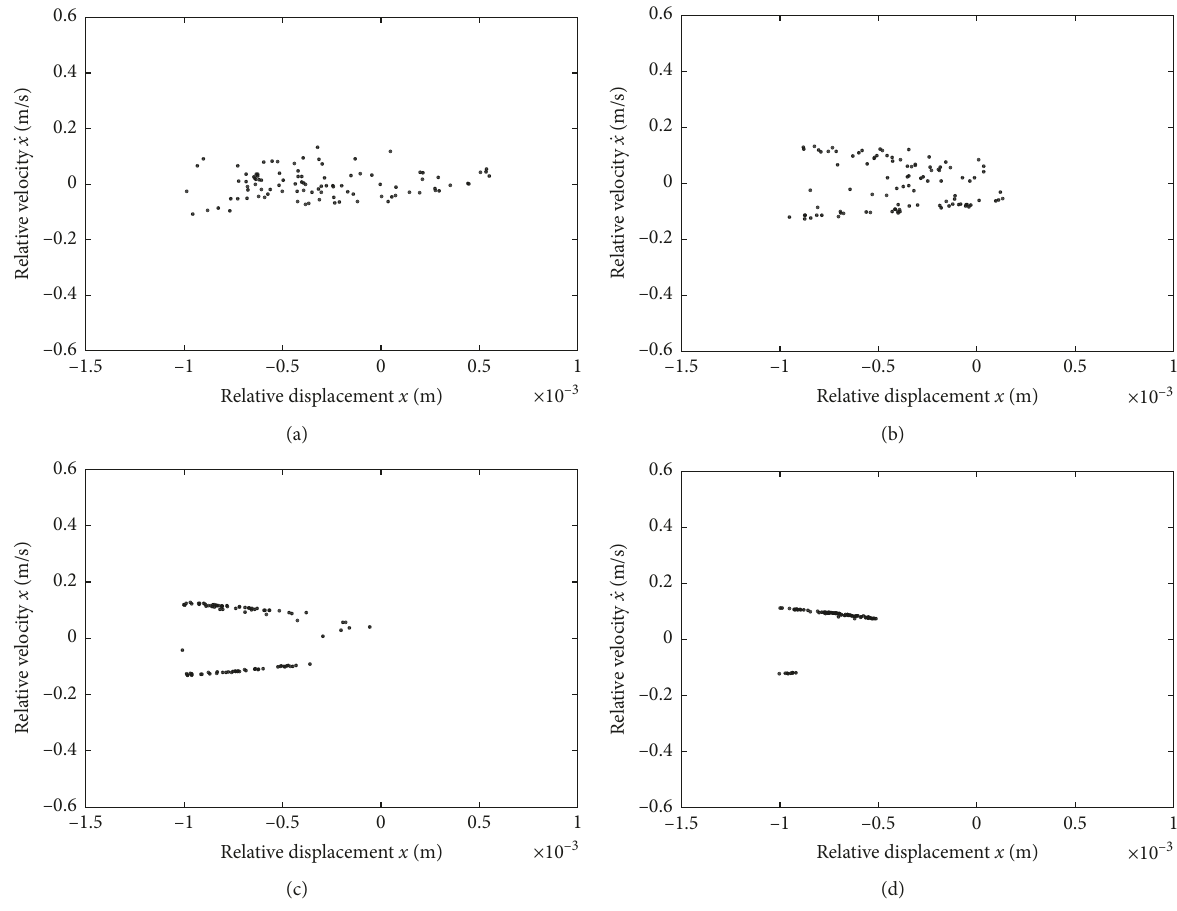
Figure 14: Poincar´e portrait of 2-DOF nine-bar mechanism for different friction coefficient: (a) c (d) c f � 0 .